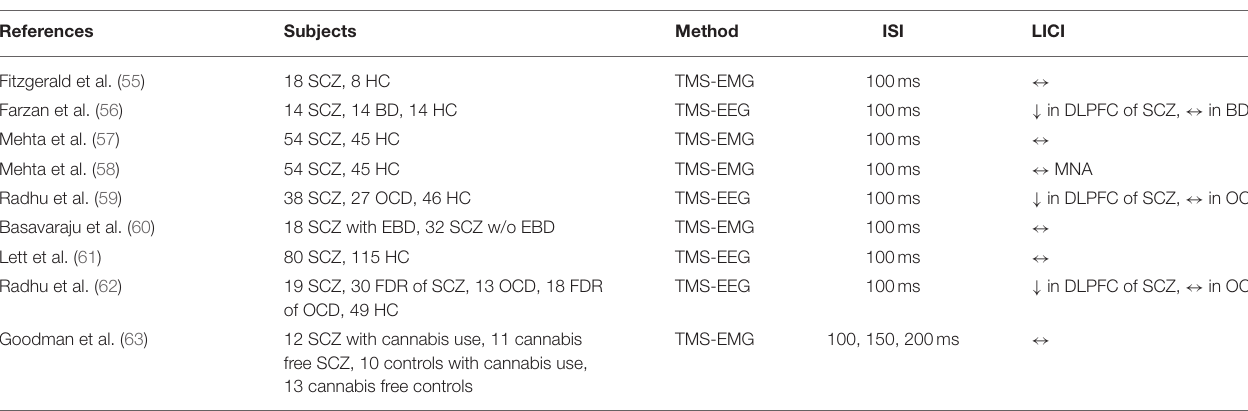
TABLE 5 | LICI in patients with